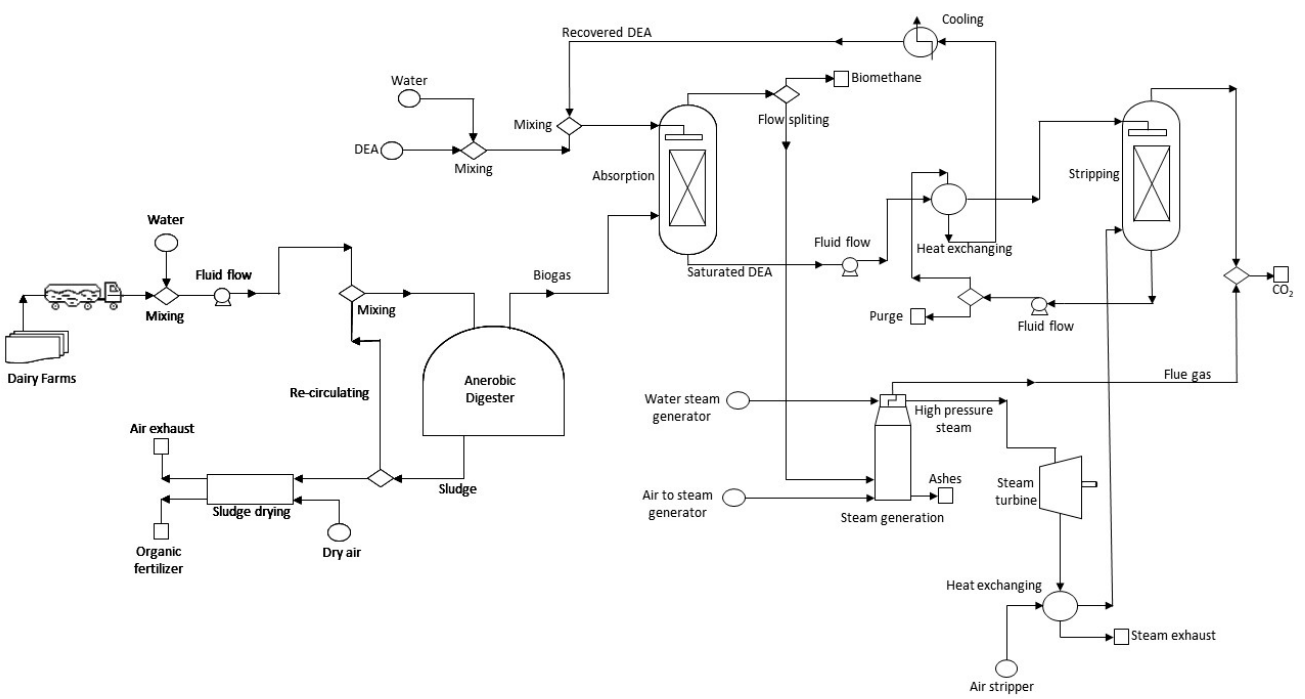
Figure 1. Design of centralized bioenergy unit.